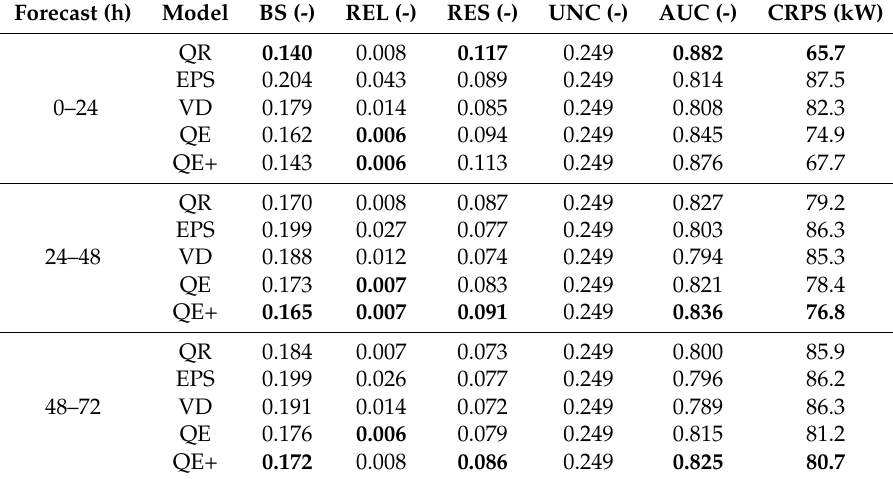
Values in bold are relative to the best performance for each of the